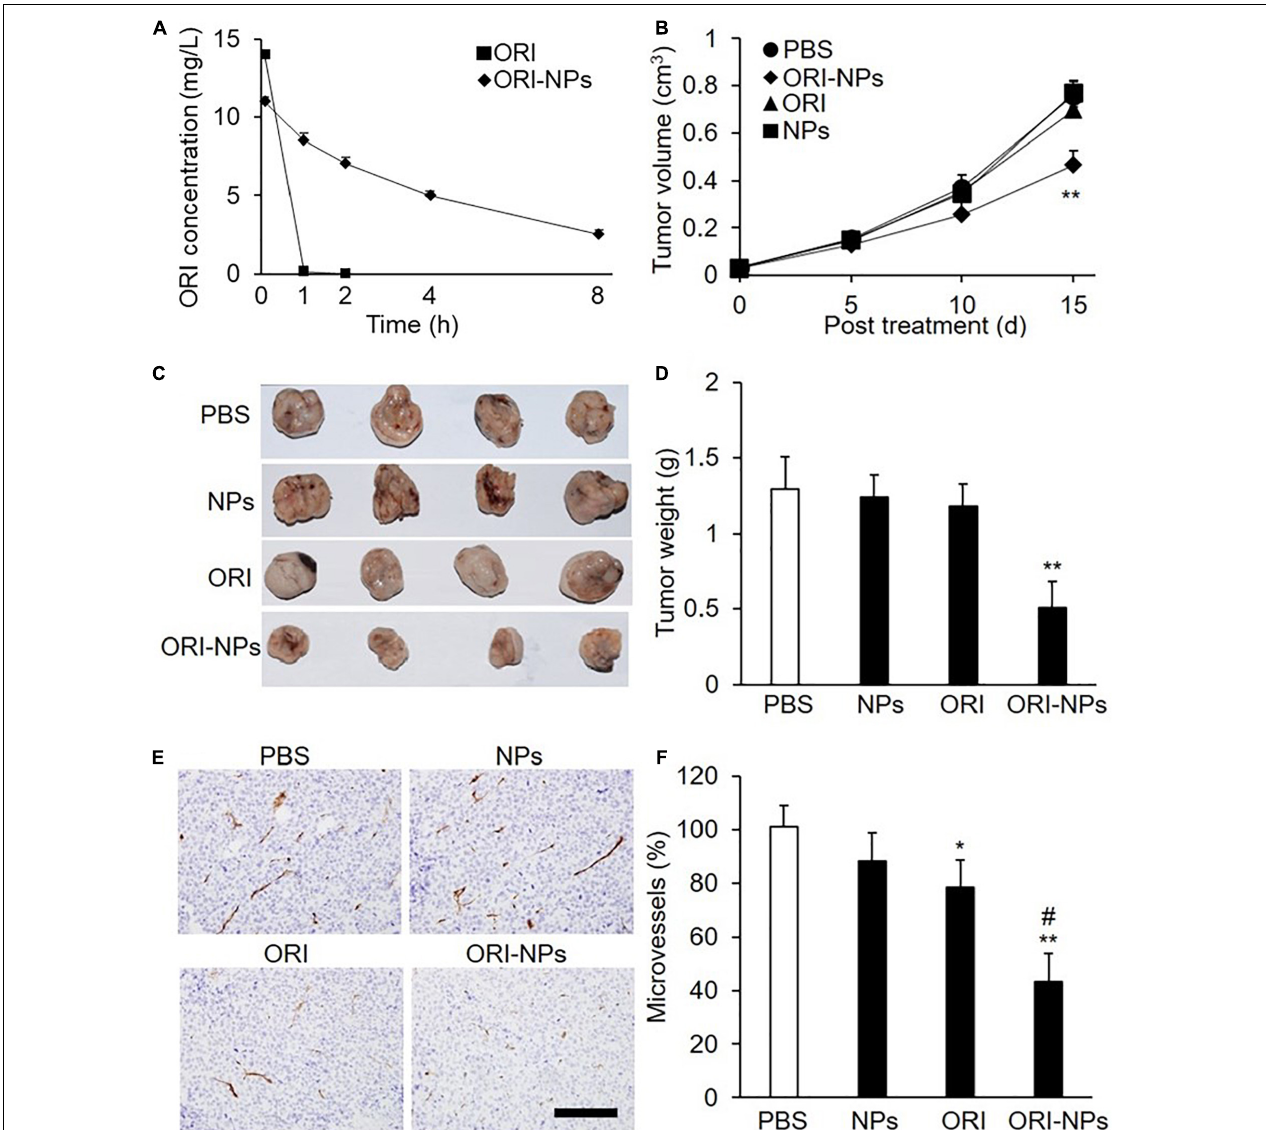
FIGURE 6 | ORI-NPs exhibits prolonged circulation time and inhibitory effects on the growth of the MCF-7 xenografts in nude mice. (A) The concentration of oridonin in blood plasma following intraperitoneal administration of free ORI and ORI-NPs in nude mice at the dose of 10 mg/kg for different time. (B) Tumor size measured using a caliper and expressed as volume (cm 3 ) according to the formula: tumor volume = (length × width 2 )/2. MCF-7 cells (1 × 10 7 ) were inoculated subcutaneously into the flanks of nude mice. Ten days later, the mice were intraperitoneal administrated with saline, ORI, blank NPs or ORI-NPs ( n = 5 , 10 mg/kg) once daily for 15 days. (C) Representative micrographs of tumors at study end point. (D) Quantification of tumor xenograft weights at days 25 after inoculation. (E) Representative micrographs of microvessels stained with anti-CD31 antibody. Data representative of five independent experiments. Scale bar = 100 µ m. (F) Quantification of microvessel numbers in tumor xenografts. (** P < 0.01 versus PBS; # P < 0.05 versus ORI).